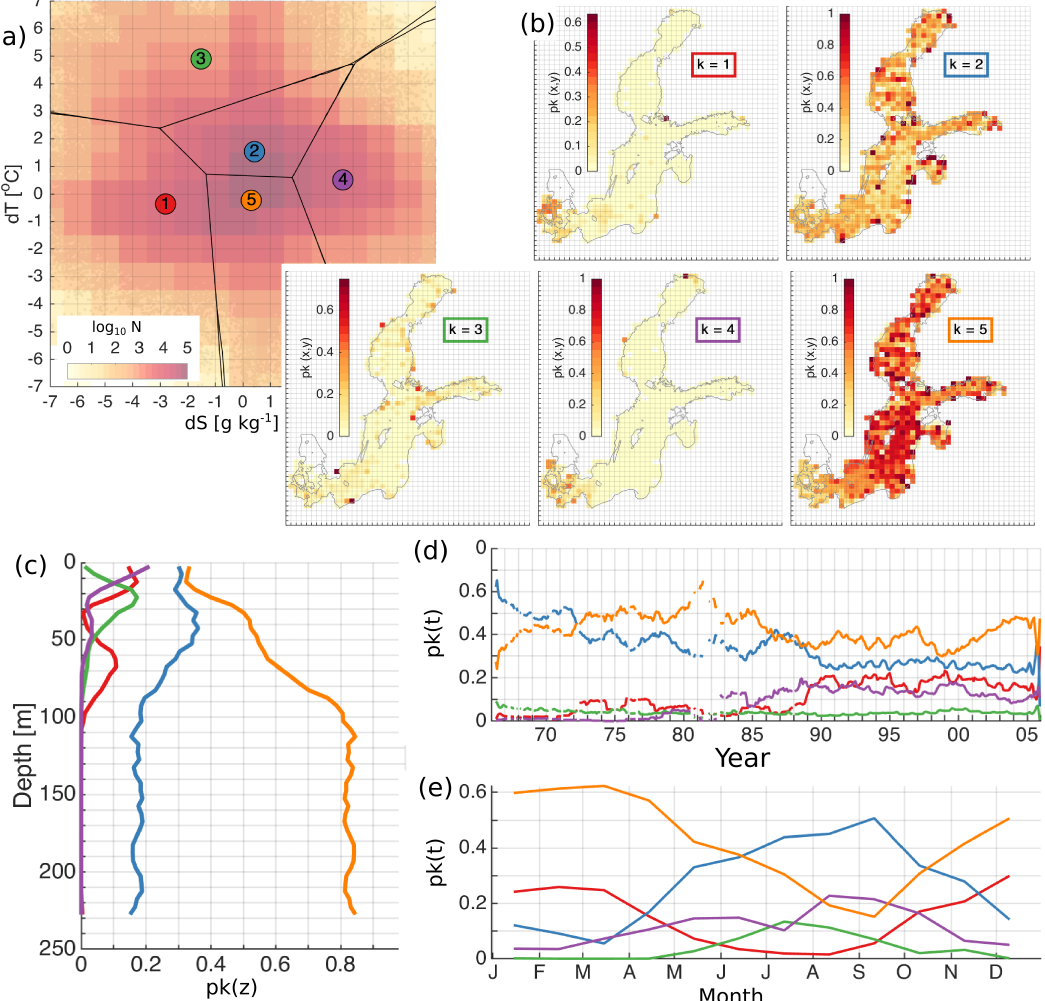
Figure B2. The distribution of the error clusters for K = 5 (a) . The coloured map shows logarithmic distribution of the number of salinity and temperature error pairs (model minus observation) in the 2-dimensional error space (a) . Error bins have a resolution of 1 ◦ C for temperature and 1gkg − 1 for salinity (a) . The spatial (b) , vertical (c) , temporal (d) , and seasonal (e) distribution of the share of error points belonging to the four different clusters (b) . The share, p(k) , representing the share of the error points belonging to the cluster k , is calculated as explained in Sect. 2.4. The horizontal bins have a resolution of 25km × 25km (b) , vertical bins have a resolution of 5m (c) , and temporal and seasonal bins have a monthly resolution (d,e) . The lines (d) have been smoothed using a running mean with a 12-point window size. Line colours correspond to the colours of the clusters in (a)